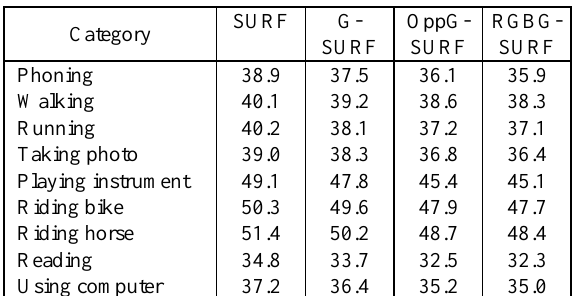
Table 2. False rejection rates for nine action categories (%)